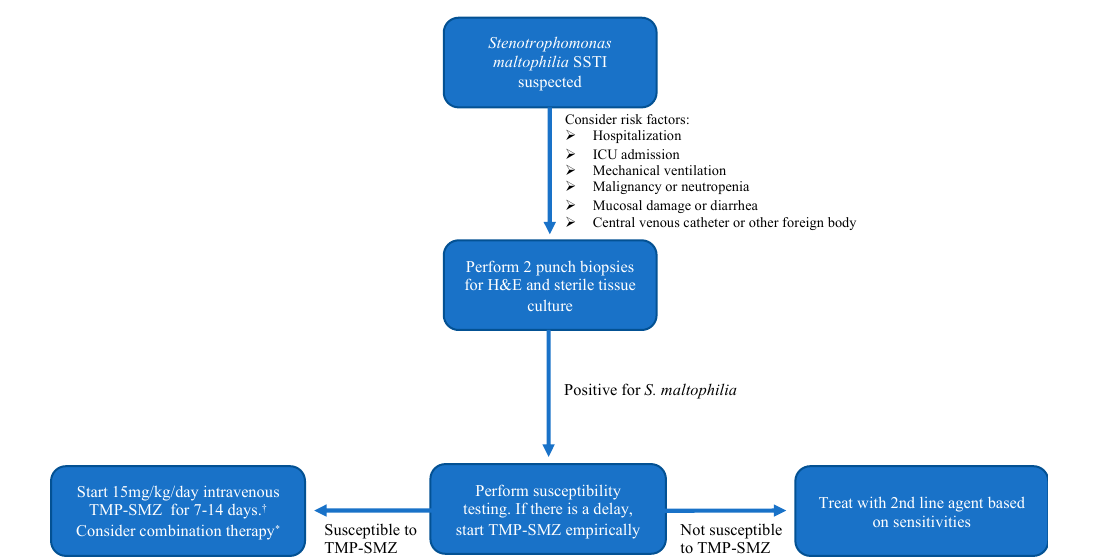
Figure 4. Diagnostic and treatment algorithm for the patient with suspected S. maltophilia SSTI. † In the case of sulfonamide allergy, desensitization may be pursued. If this is not possible, treatment with levofloxacin or minocycline should be initiated if the culture demonstrates sensitivity. * Consider combination therapy such as trimethoprim–sulfamethoxazole plus a third-generation cephalosporin or extended-spectrum penicillin [15].